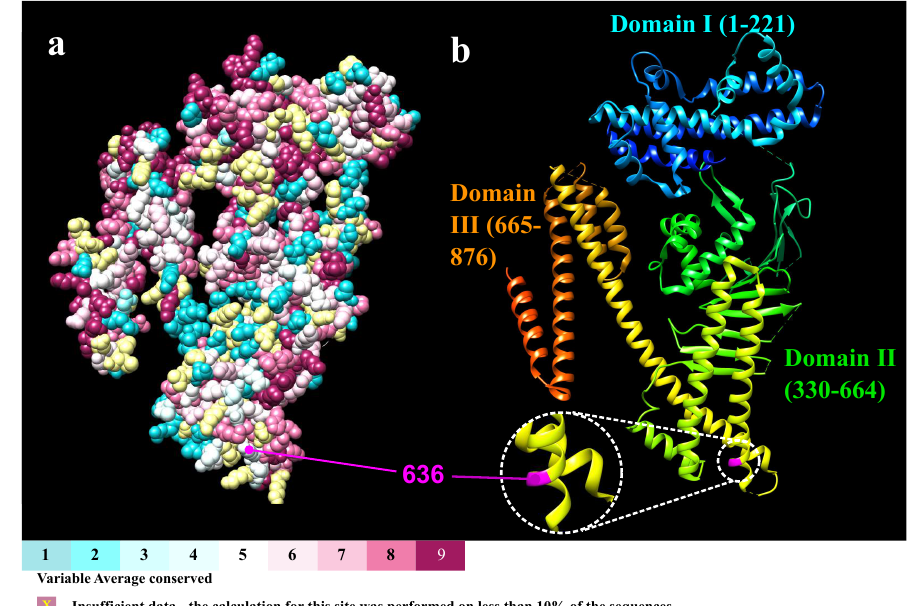
Figure 1. Consurf Results obtained from AQUA MSA: ( a ) amino acids with conservation scores of CagA indicating the location of residue 636; and ( b ) ribbon view of each domain is specified showing the location of residue 636 in